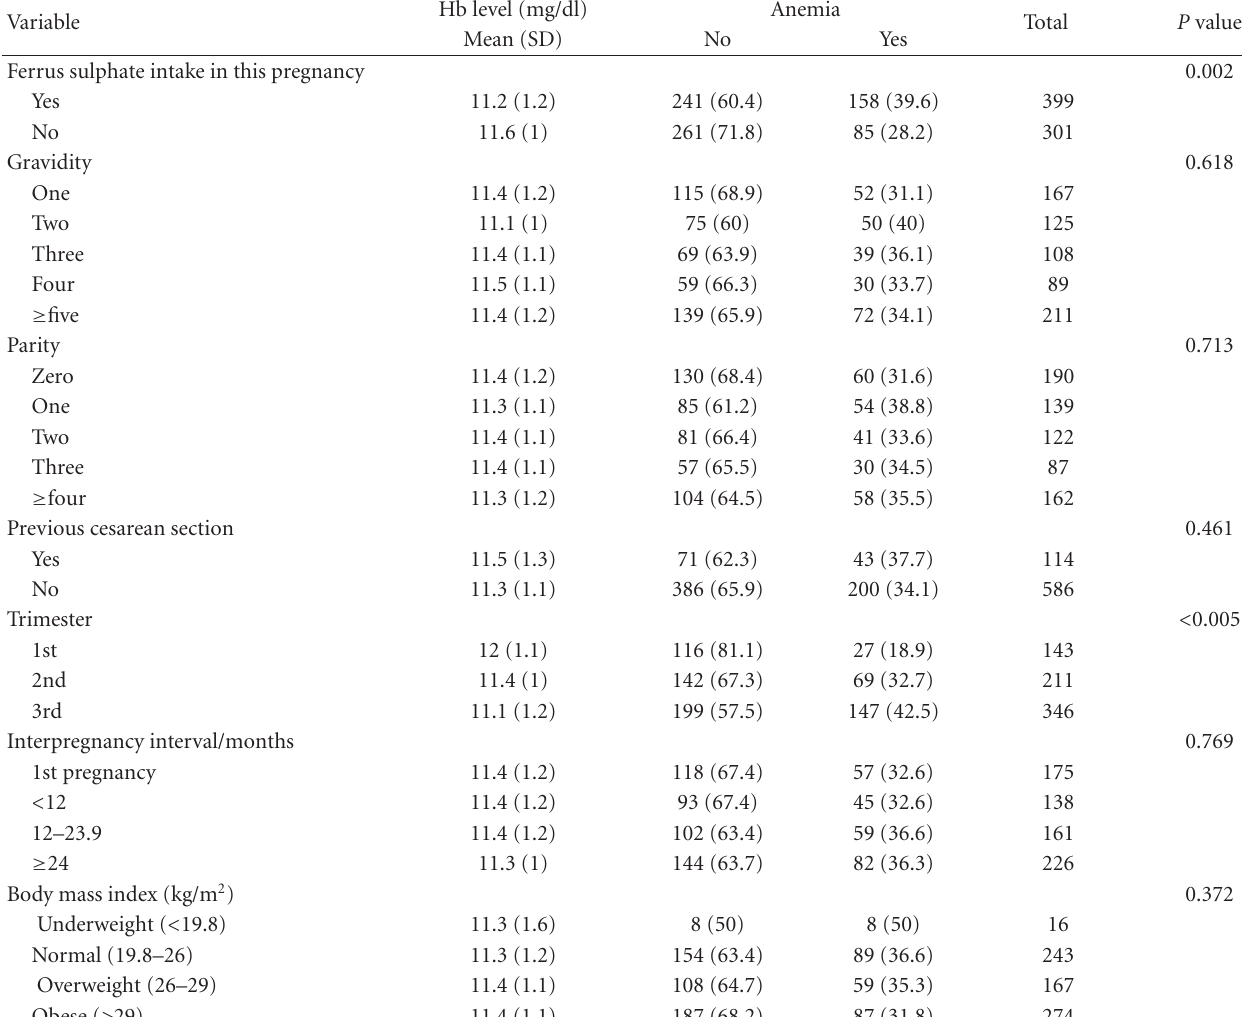
Table 3: Prevalence of anemia according to obstetrical